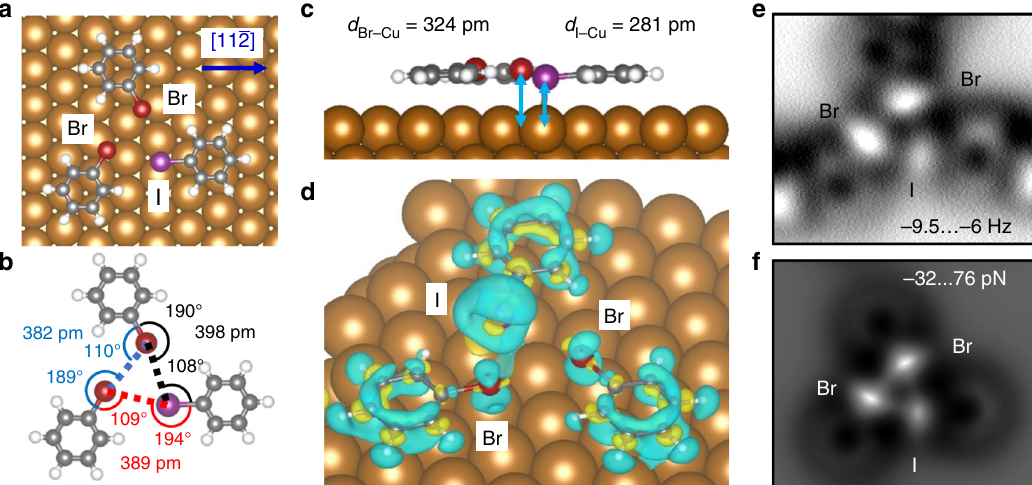
Fig. 4 DFT calculated structure and charge transfer of a halobenzene Br ∙∙∙ Br ∙∙∙ I windmill on Cu(111). a Top view of DFT calculated windmill structure consisting of two bromobenzenes and one iodobenzene on Cu(111) revealing the adsorption positions of the molecules. The 11 (cid:1) 2 the blue arrow. b Bonding angles and distances of structure in ( a ). The effective bonding angles of the three halogen bonds are 118°, 119°, and 123°, respectively. c Side view of ( a ). Blue arrows indicate the distance between the halogens and the Cu(111) surface plane. d Differential charge density at the 10 − 4 e bohr − 3 isosurface (yellow = charge accumulation, blue = charge depletion). Due to the interaction with the Cu(111) surface, charge is depleted from the negative belts (blue regions) and accumulated at the σ -holes (yellow regions). For iodine this effect is much stronger than for bromine. e AFM constant height image of a Br···Br···I windmill structure of I para Br meta -TP on Cu(111) (see details in Fig. S3). f Simulated force map for the structure in ( a